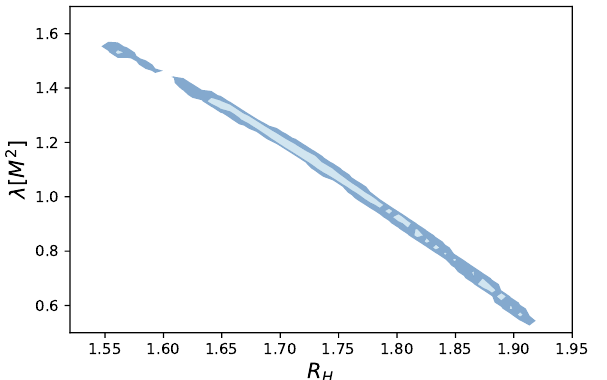
Figure 7. The figure shows the parametric plot of λ versus R H with 68% and 96% confidence